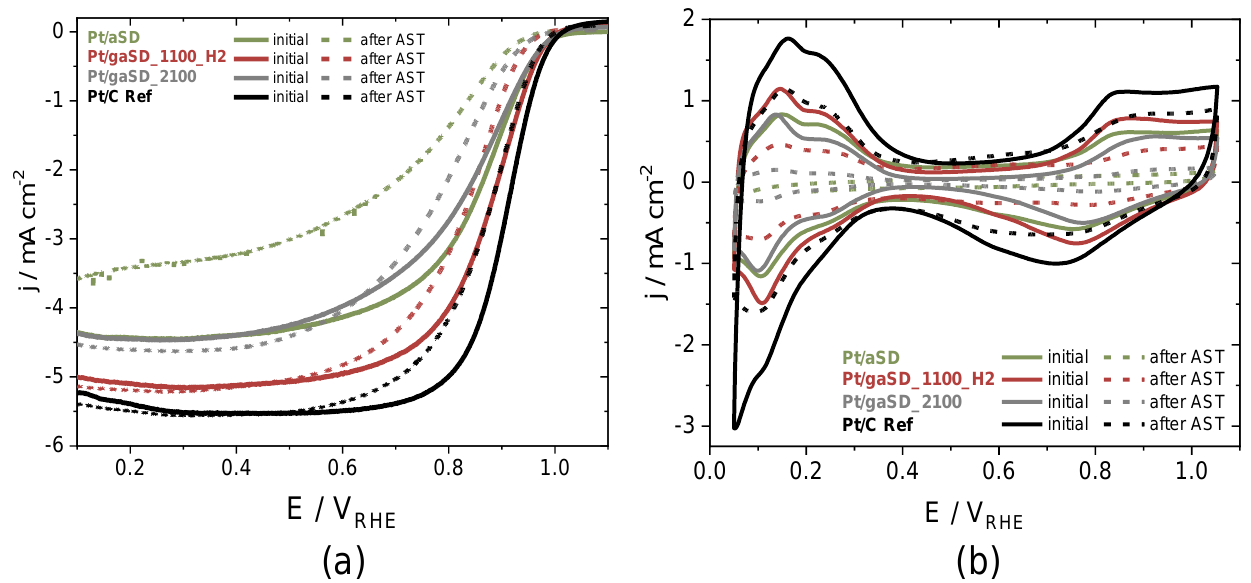
Figure 6. Electrochemical characterization of Pt/aSD, Pt/gaSD_1100_H2, Pt/gaSD_2100 and Pt/C ref before and after the AST (0.6 – 1.5 V RHE , 5000 cycles) as ( a ) ORR activity curves in O 2 − saturated 0.1 M HClO 4 electrolyte and 1600 rpm and ( b ) CVs in N 2 -saturated electrolyte. Catalyst loading was 40 µg Pt cm −2 .